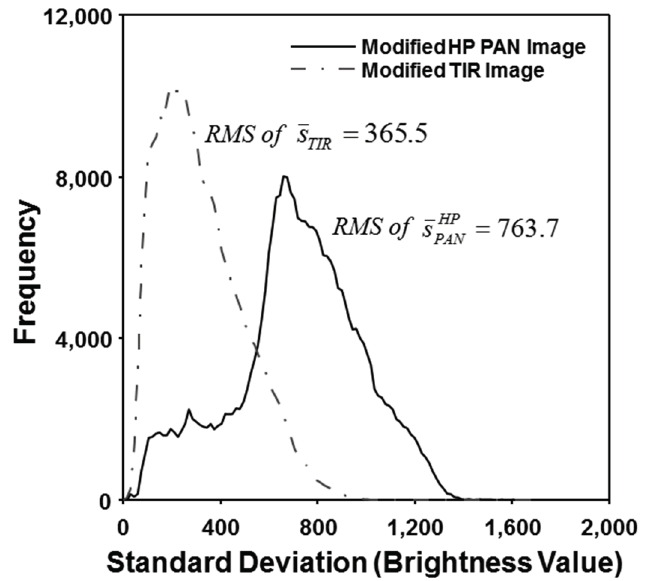
Figure 4. Histograms of local standard deviations calculated by using the window kernel of 21 × 21 from the modified HP PAN and the modified TIR